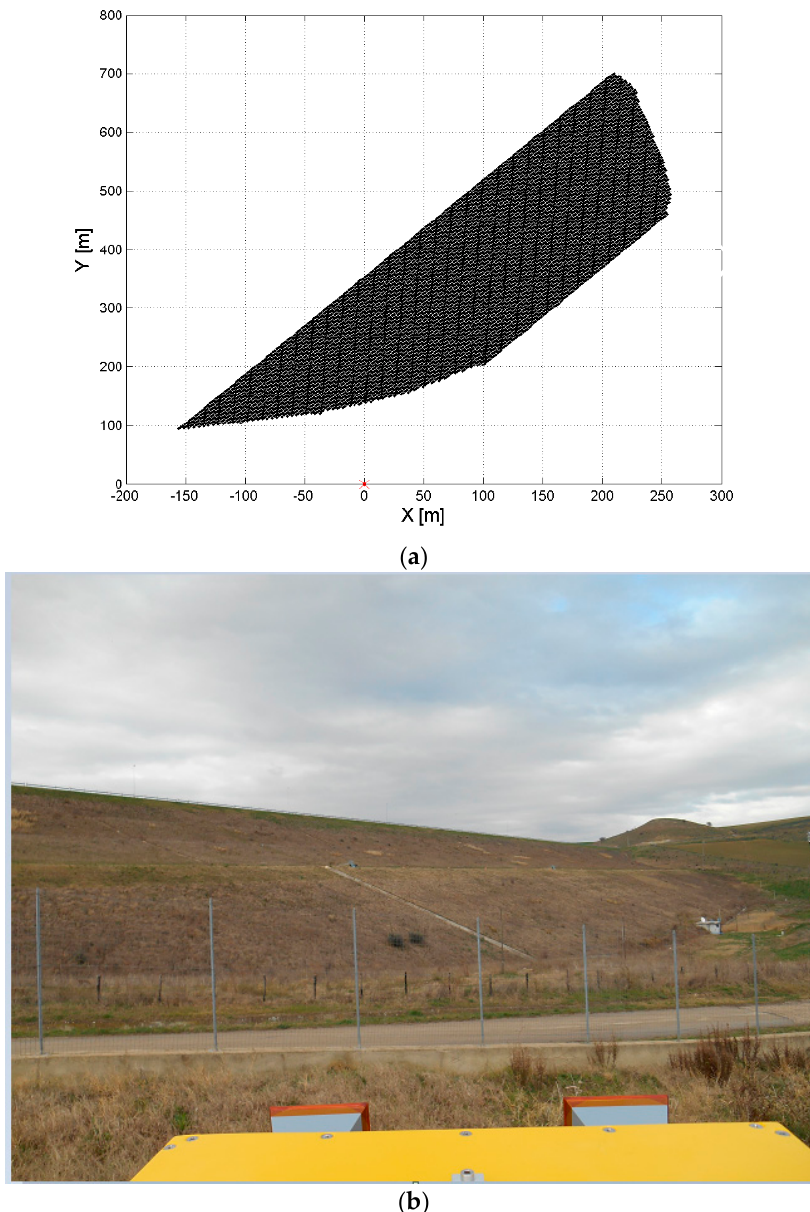
Figure 7. Acquisition geometry at the Marana-Capacciotti dam: ( a ) Map of the dam downstream surface re-projected in the Cartesian reference system centered at the GBSAR rail center and with the x-axis given by the rail direction. The GBSAR is located at the position ( x = 0, y = 0); ( b ) photo of the dam surface taken from the GBSAR installation site.